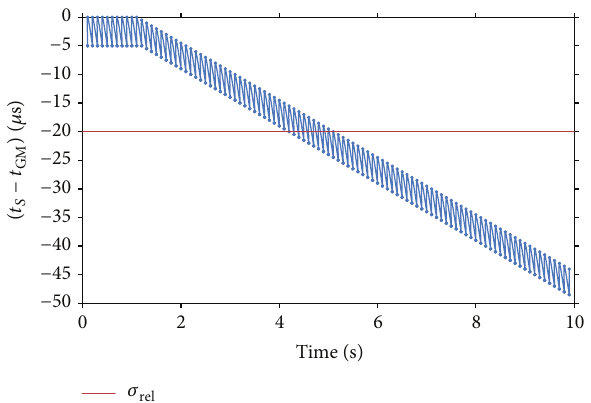
Figure 11: Time deviation between the grandmaster clock and the slave clock. Linearly increasing